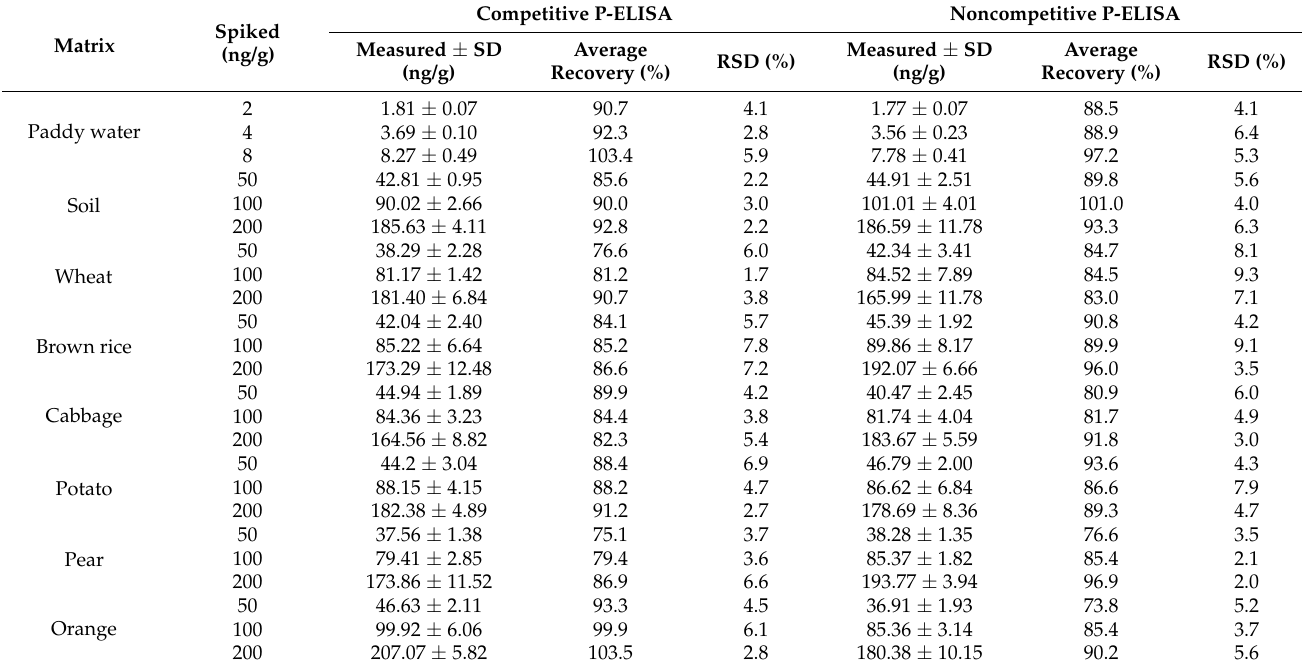
Table 3. Recoveries of spiked samples for IMI ( n = 3).